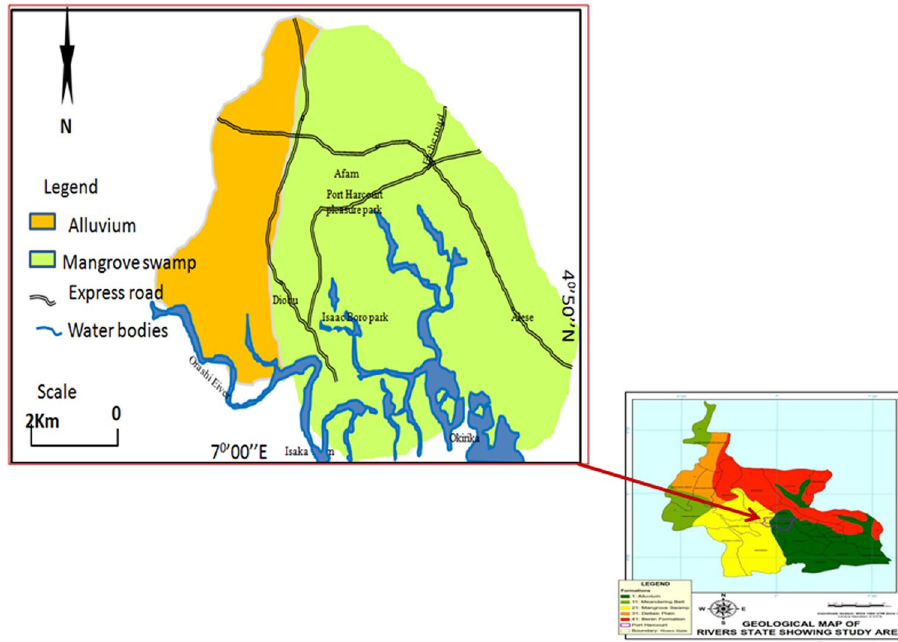
Fig. 1 Geology of the study